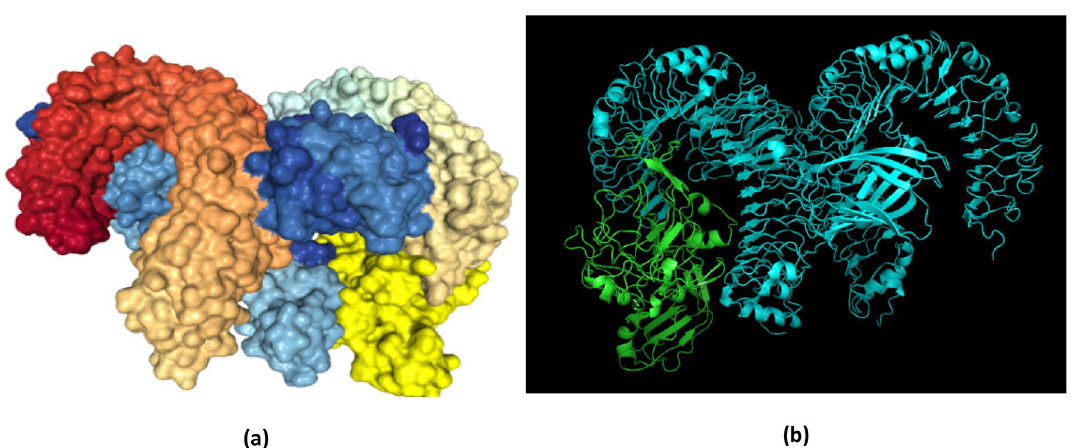
Figure 10. Molecular docking of subunit vaccine with the immune receptor—TLR4. ( a ) Docked image of the chimeric protein generated by HDOCK server having a binding energy score of -314.02. The rainbow-colored complex represents the TLR4 receptor molecule, while the golden-yellow colour denotes vaccine construct V1. ( b ) ClusPro generated model 5, which represents the protein–ligand complex (cyan–green). The lowest binding energy of -973.2 kcal was achieved for this model (Chimera 1.15—https:// www. cgl. ucsf. edu/ chime ra/ downl oad. html). PDB ID of the HLA Vaccine construct